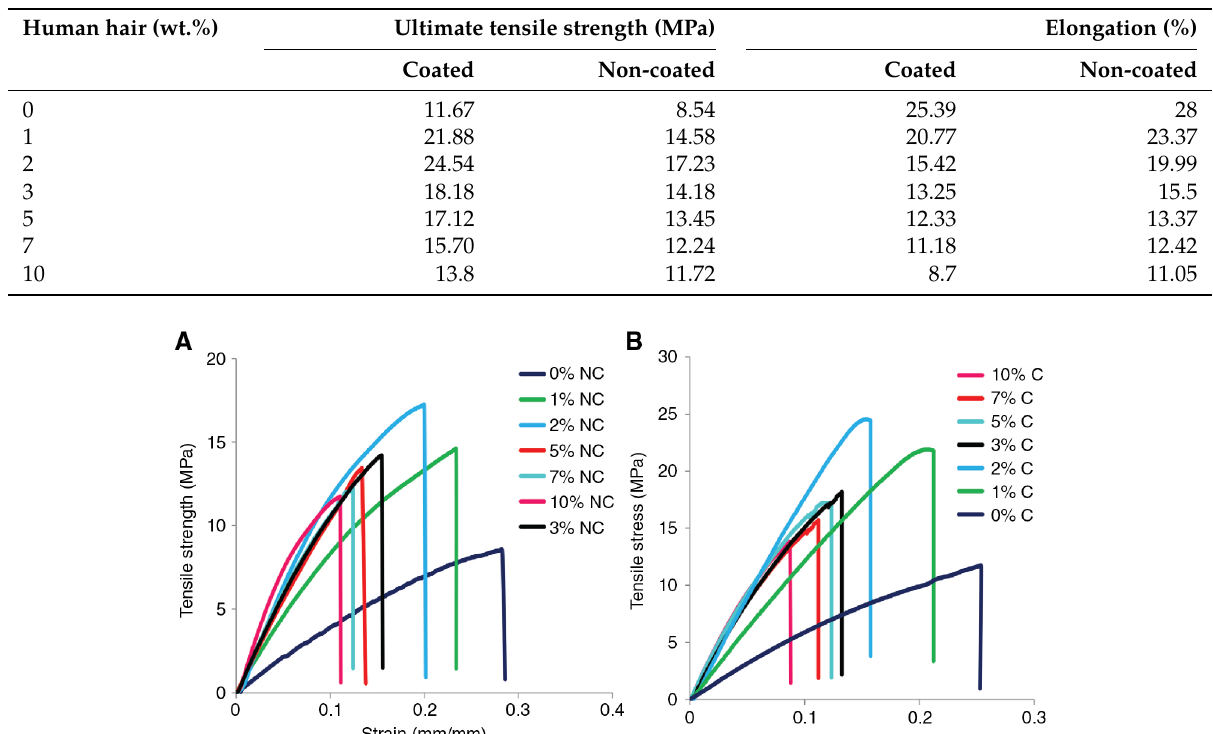
Figure 2: Tensile stress-strain diagram for human hair reinforced phytagel modified SPI composite (A) non-coated and (B)